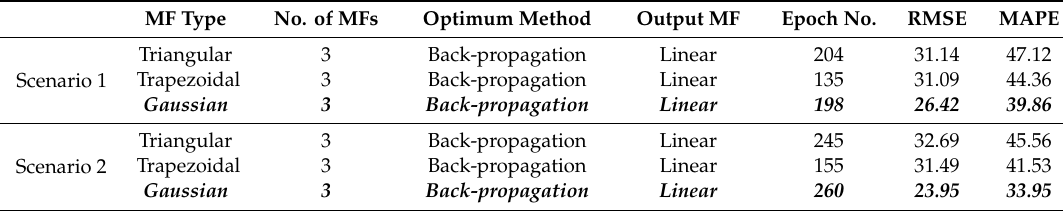
Table 4. ANFIS training results (mortality rate).